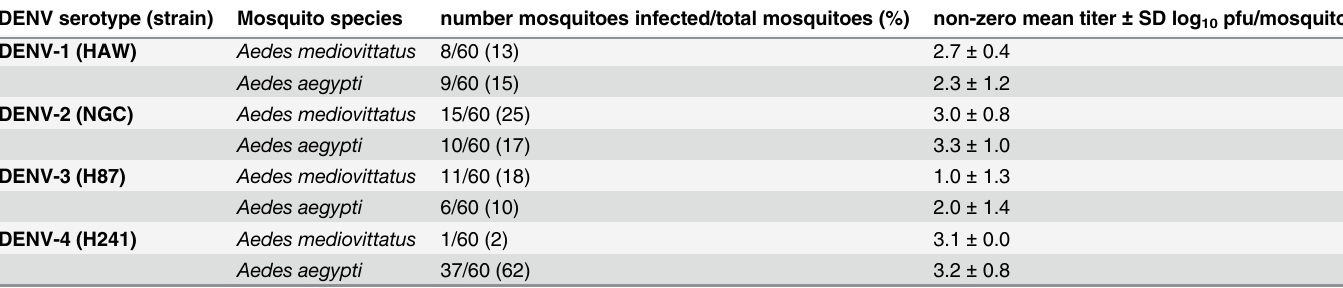
Table 1. Infection rates and body titers of Aedes mediovittatus and Aedes aegypti mosquitoes 14 days post bloodmeal. DENV serotype (strain) Mosquito species